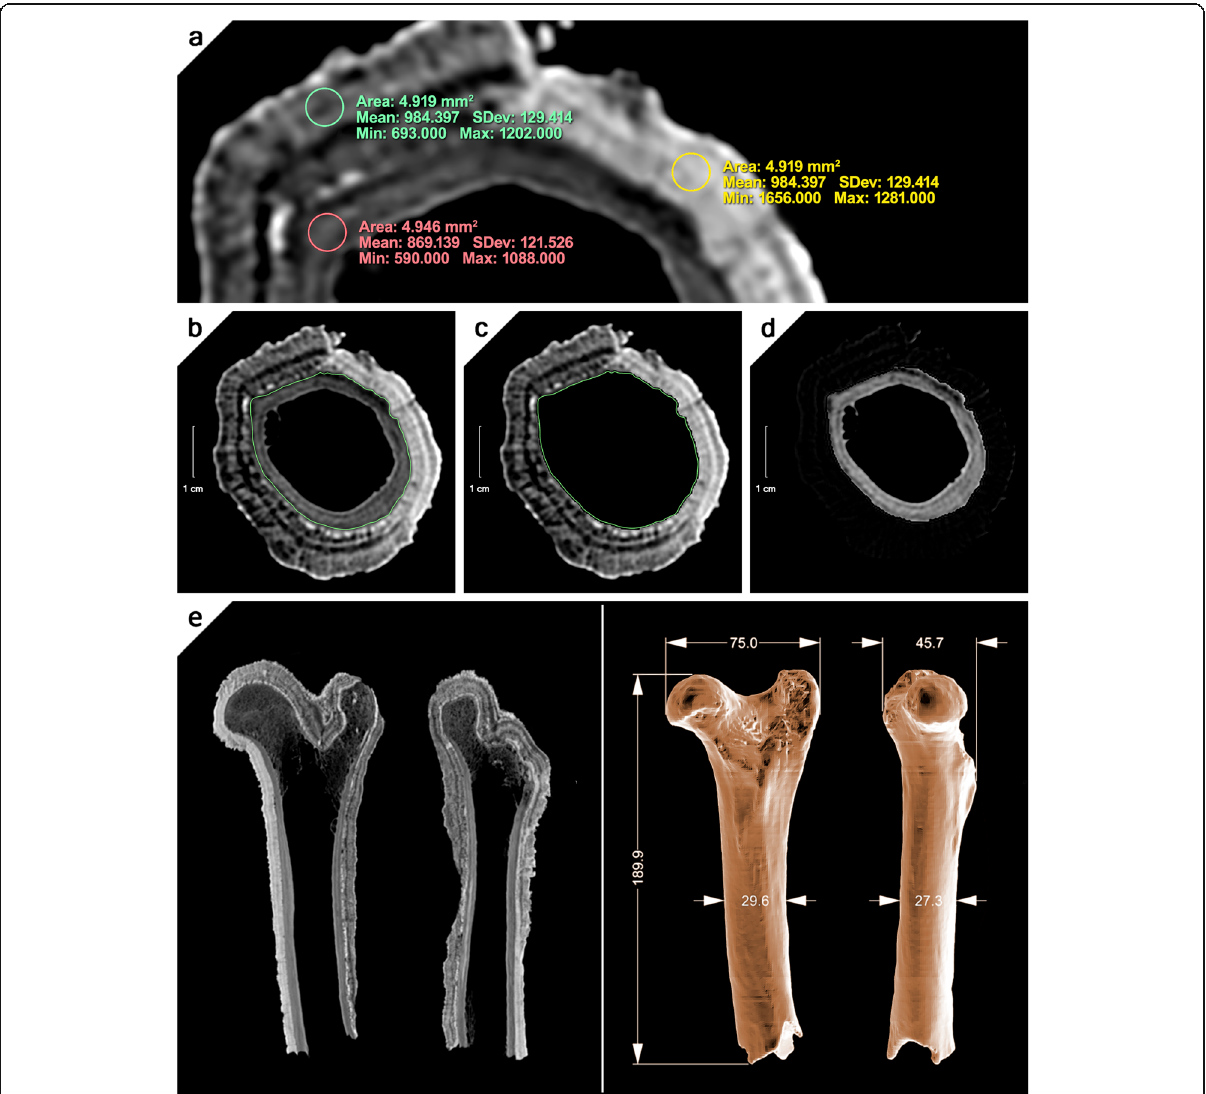
Fig. 3 Radiographic analysis and virtual removal of speleothemic deposits. a Segmentation of the incrusted bone fragment was a particular challenge due to the sometimes very similar densities of the partially fossilised bone fragment and the surrounding calcite mineral. b – d A combined manual and HU-threshold based segmentation protocol, previously developed for such applications by one of the authors (P.E.), was therefore applied. e Osteological measurements from one of the virtual 3D bone models. The model differing the least from the remaining two models was chosen (Reader 1). Correlative cross-sections from the CT scan are represented. The mean difference between virtual osteological measurements and direct radiological measurements is 0.4 mm ± 0.3 mm (mean ± standard